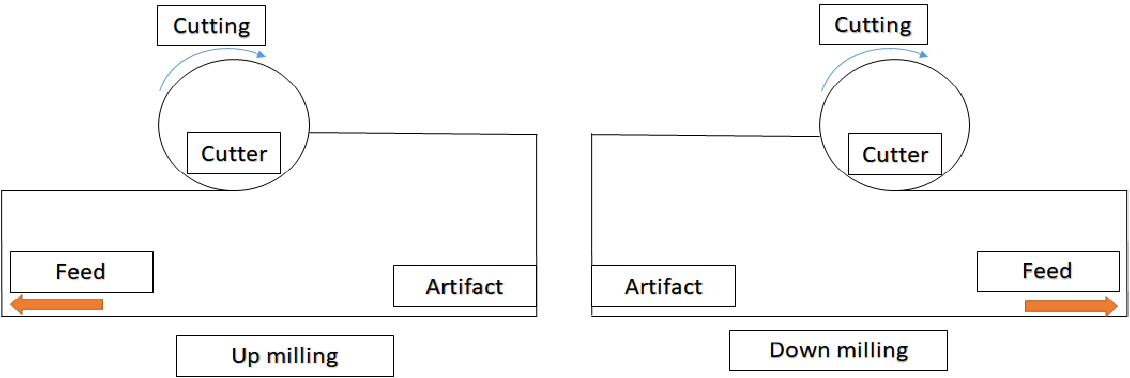
Figure 6. Triaxial CNC dental handpiece used in the cutting experiment.